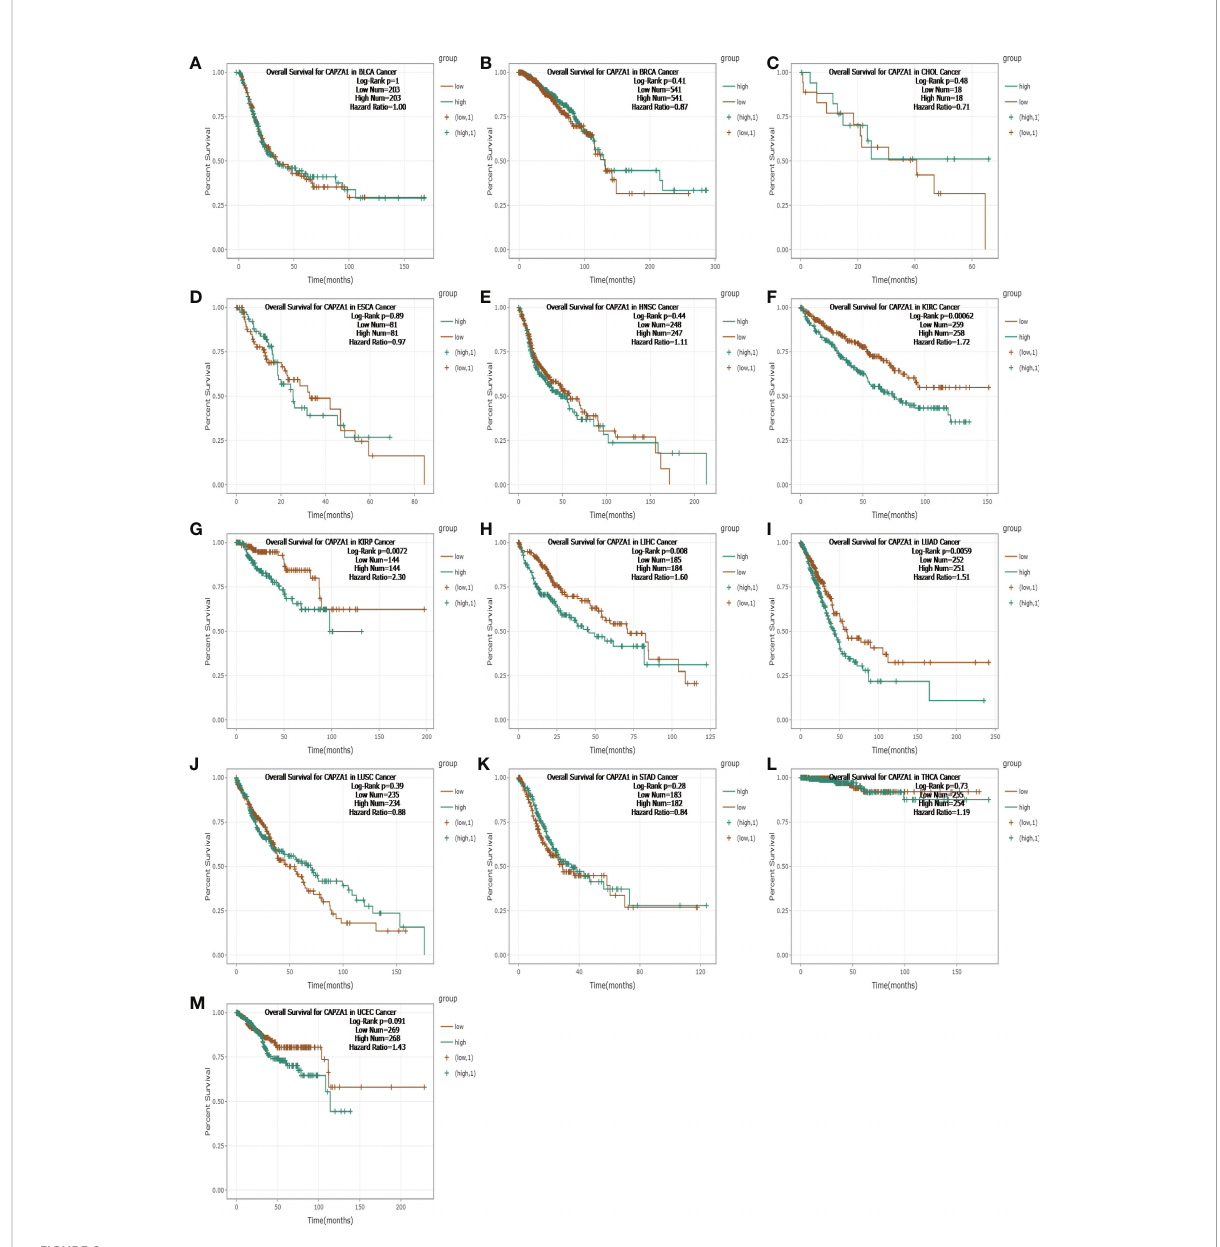
FIGURE 2 The overall survival (OS) analysis for CAPZA1 in various human cancers determined by starBase. (A – M) The OS plot of CAPZA1 in BLCA. (A) , BRCA (B) , CHOL (C) , ESCA (D) , HNSC (E) , KIRC (F) , KIRP (G) , LIHC (H) , LUAD (I) , LUSC (J) , STAD (K) , THCA (L) , and UCEC (K)